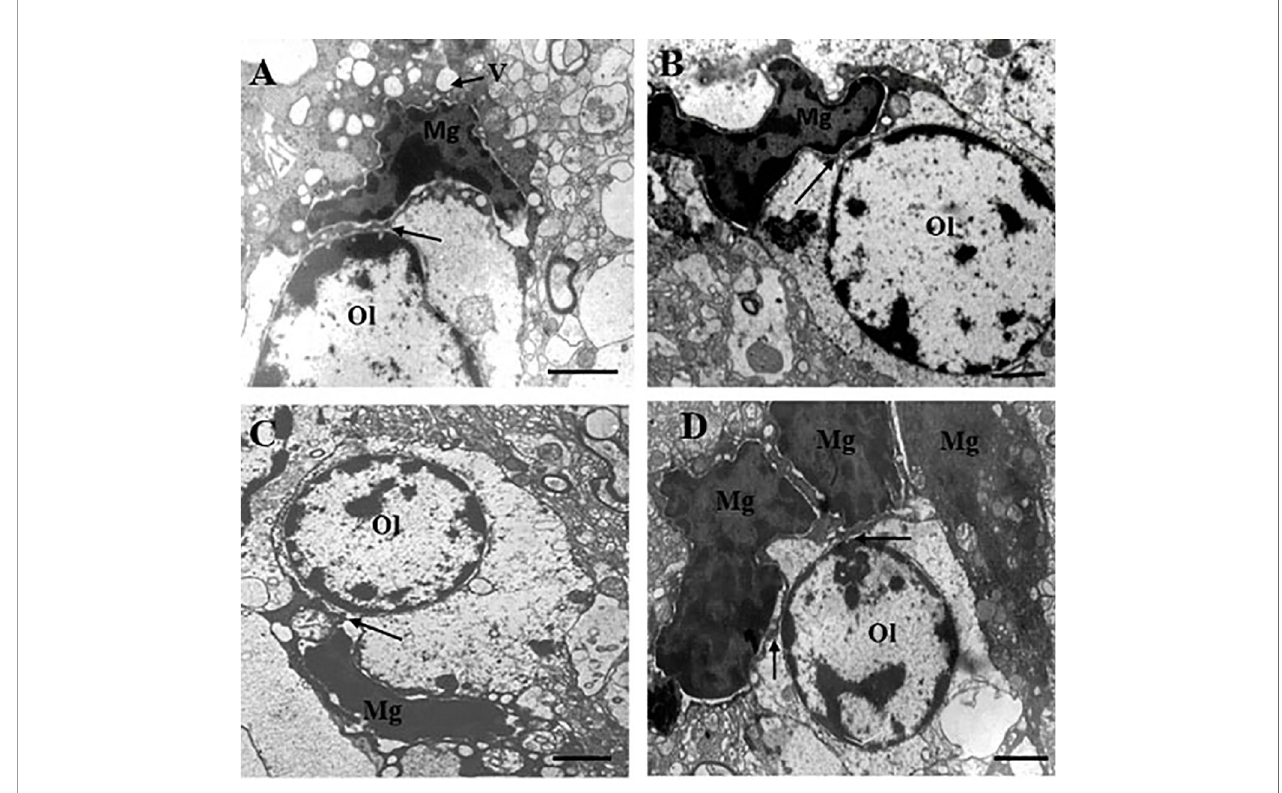
FIGURE 2 | These micrographs from layer 5 of the prefrontal cortex show microglia adjacent to oligodendrocytes from the SPNS subgroup. Dark dystrophic microglia (A) . Ameboid microglia (B) , signs of apoptosis (dark nucleus and small rim of dark shrunken cytoplasm) (C, D) . All microglia showed contacts with the nuclei of oligodendrocytes ( A – D , arrows). A group (cluster) of three microglia surrounding dystrophic oligodendrocyte (D) . Ol, oligodendrocyte; Mg, microglia. Scale bar=1